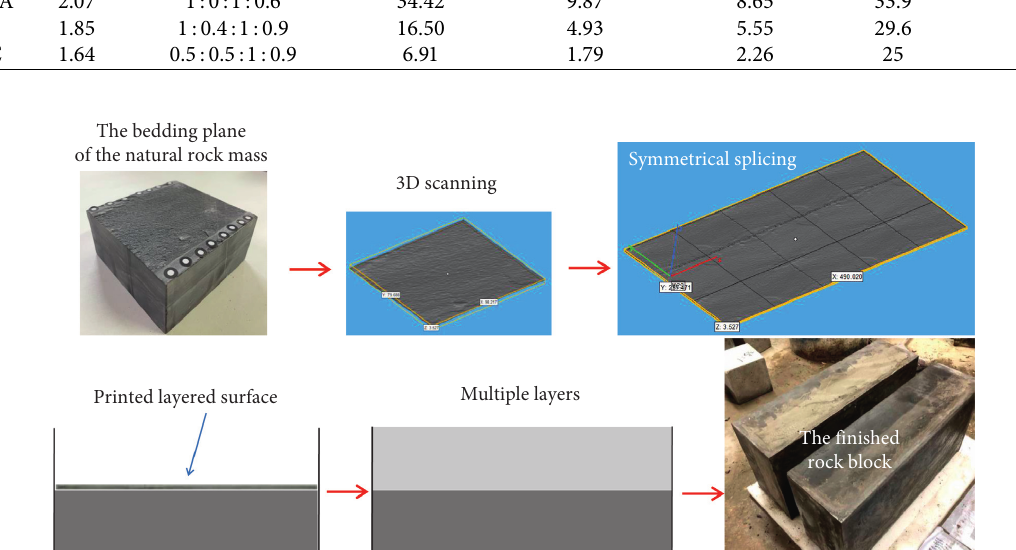
Figure 2: The production of the layered rock specimen using 3D scanning and 3D